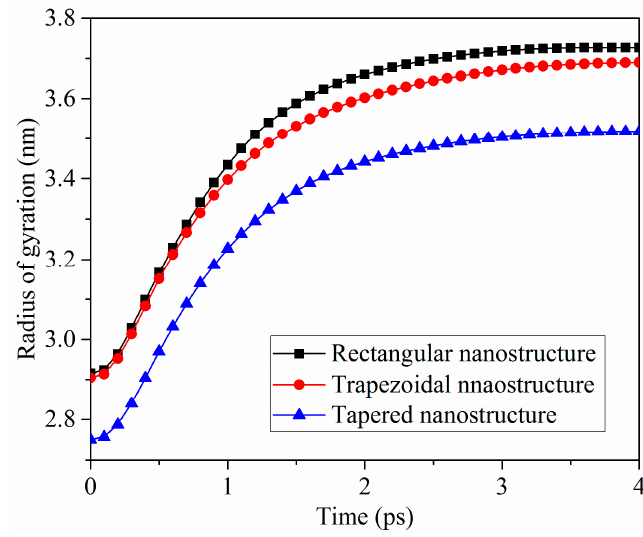
Figure 4. Radii of gyration of nanostructures with different shapes.